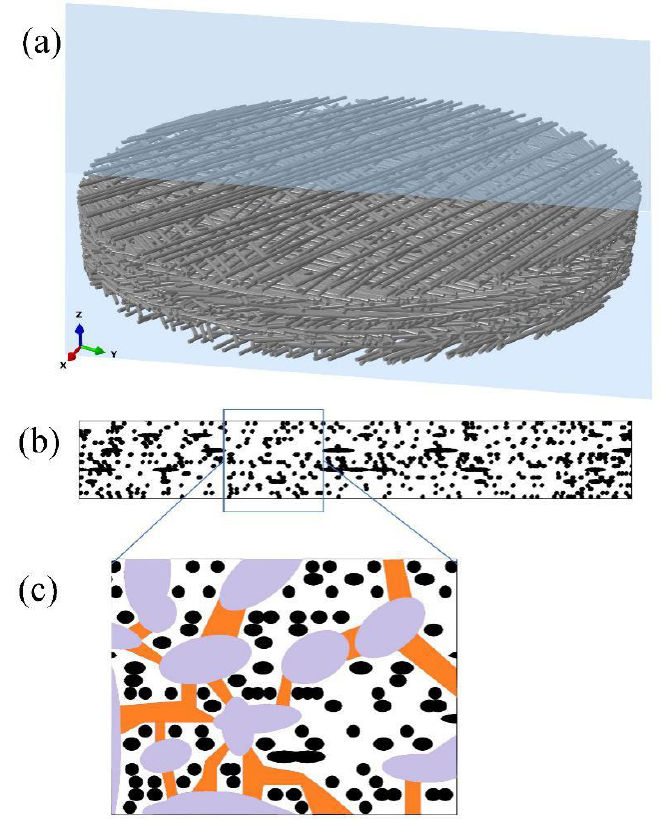
Figure 2. Three-dimensional reconstruction images of intervessel pit membrane. ( a ) A general view of intervessel pit membrane showing multiple layers of randomly distributed cellulose microfibrils. The blue slide shows direction of splitting in the radial view assuming pit membranes are circular. ( b ) Cellulose microfibril distribution of pit membrane in Figure 2a from the radial view, and black shapes represent cellulose microfibrils. ( c ) An enlarged view from the frame shown in Figure 2b, with pit membrane constriction illustrated. Black shapes represent cellulose microfibrils; purple shapes represent relatively larger pores in between cellulose microfibrils, and orange shapes represent constrictions between these relatively larger pores.